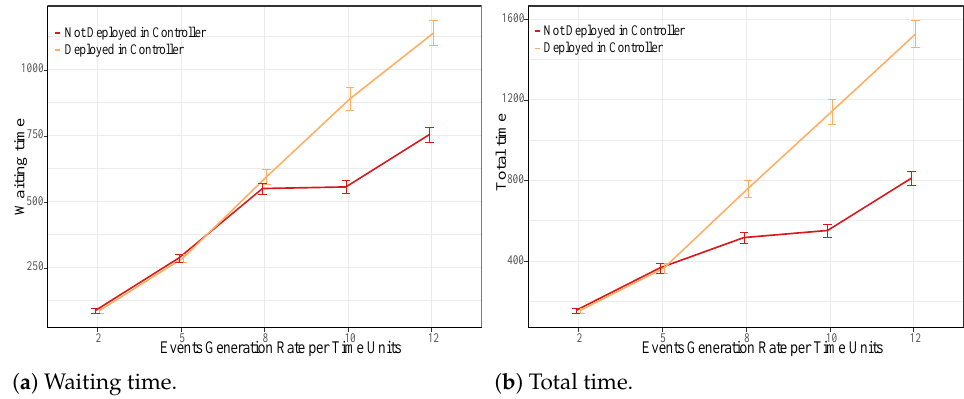
Figure 5. Average metrics time while deploying or not deploying events in the controller